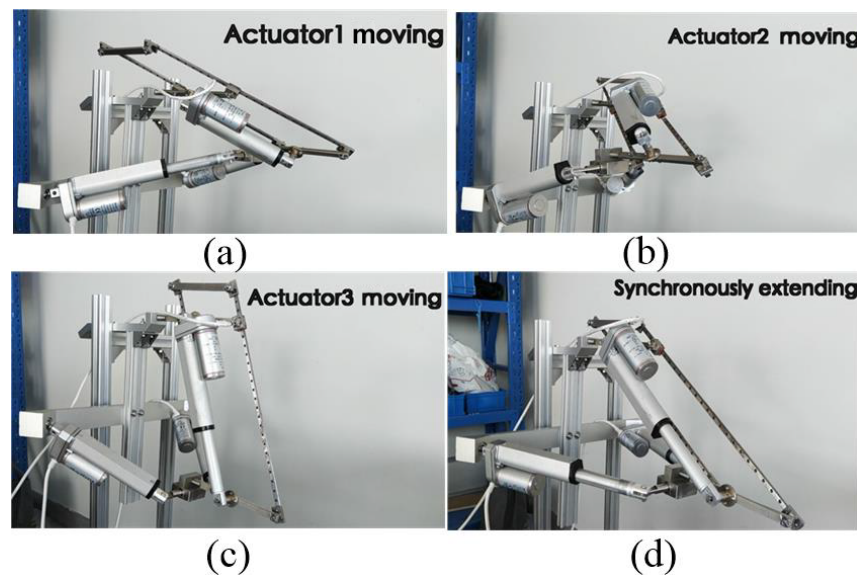
Figure 22. Motion experiments: (a) Actuator 1 moving, (b) Actuator 2 moving, (c) Actuator 3 moving, (d) Synchronously